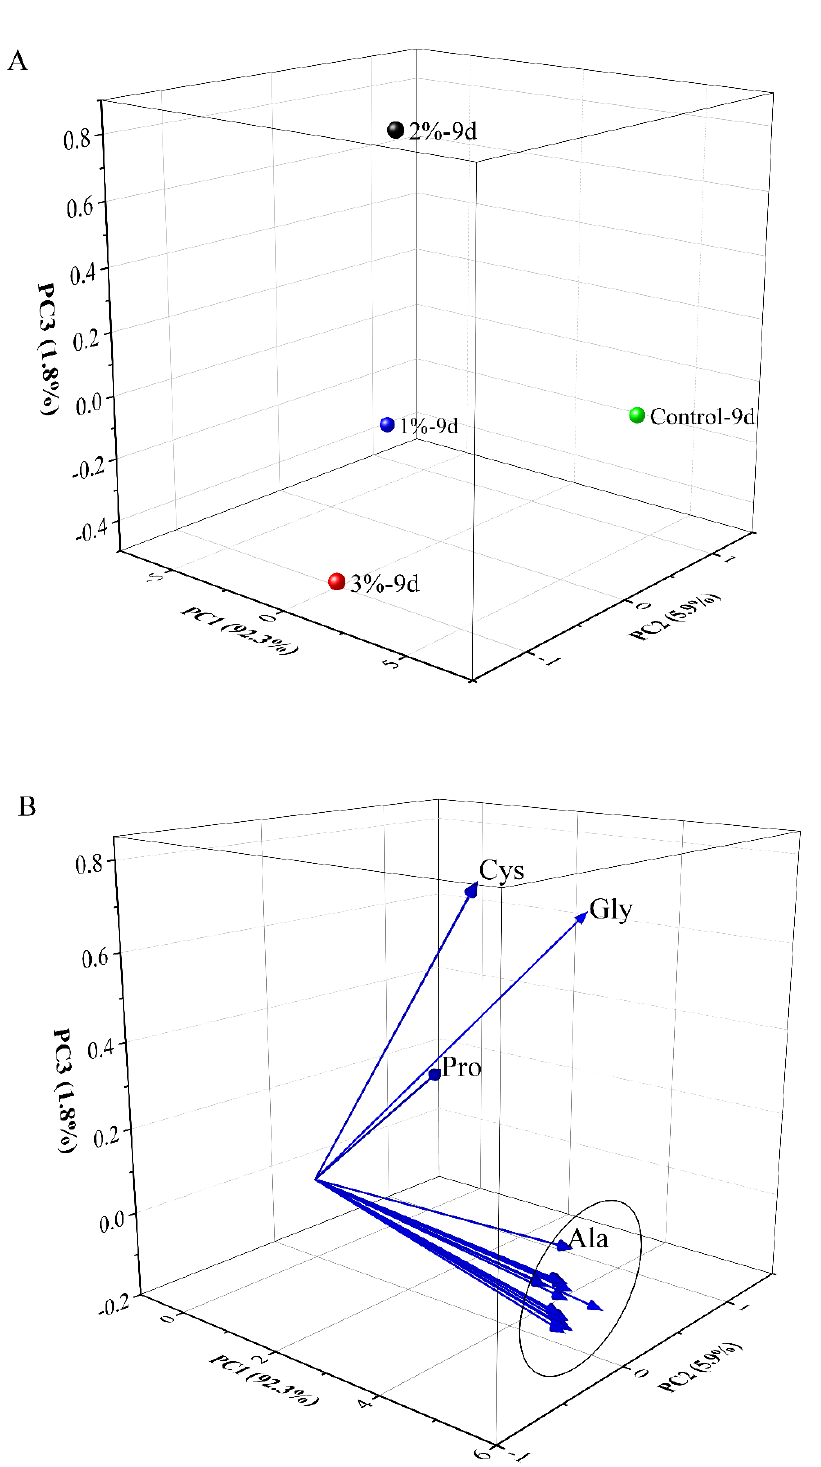
Figure 5. Principal component analysis of free amino acids in the four mulberry fermented alcoholic beverages containing mulberry leaf powder during fermentation. Score plots ( A ) and loading plots ( B ). The free amino acids detected in the four kinds of mulberry fermented beverages were analyzed by PCA using Origin 2021 software. Control represents without the addition of mulberry leaves; 1, 2 and 3% ( w / v , g/mL dry weight) represent the added amount of mulberry leaf powder.